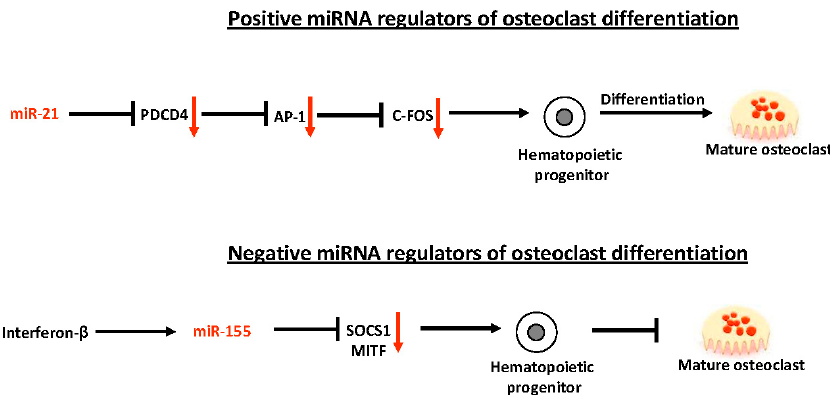
Figure 5. Schematic representation of positive ( ↑ ) and negative ( ↓ ) miRNA regulators of osteoclast